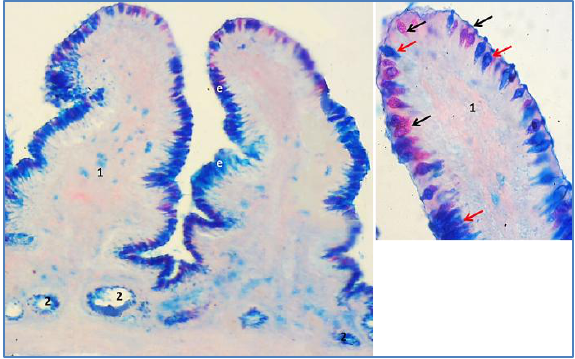
Figure, 4: The villi of coprodeum (hen turkey) shows: Lamina propria (1), epithelial tubular glands (2), epithelium (e), Alcian blue positive cells (Red arrows) and PAS positive cells (Black arrows). (Combined AB&PAS) satin. 100x and